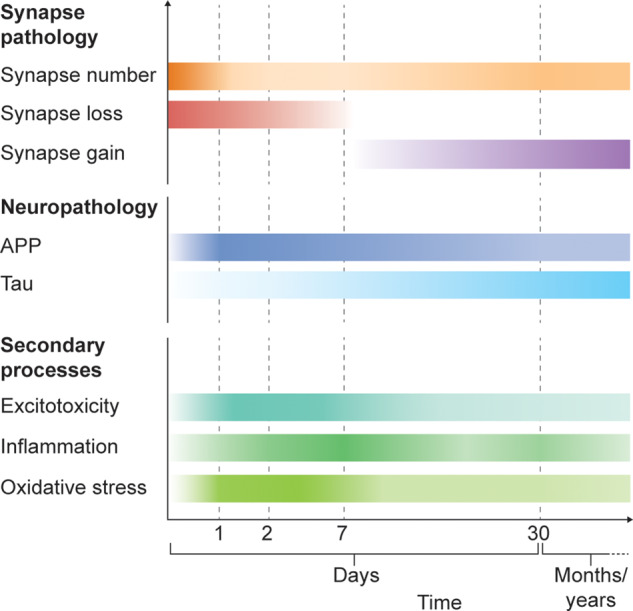

Summary of pathological changes following traumatic brain injury. After TBI, synapse density is reduced for up to 7 days, followed by a recovery which plateaus around 30 days (Scheff et al., 2005). Abnormal accumulation of APP peaks 1 day after TBI but can persist for months to years after injury (Johnson et al., 2013). Tau spreads through the brain after TBI and neurofibrillary tangles are a hallmark of chronic traumatic encephalopathy (Edwards et al., 2020). There is a rapid rise in extracellular glutamate after TBI, and levels may remain abnormally elevated up to a week from the injury (Vespa et al., 1998; Hong et al., 2001). Microglia show bimodal peaks after TBI at 7 days and then 30 days (Simon et al., 2017). Markers of oxidative stress appear rapidly after injury and may persist up to 6 months after TBI (Licastro et al., 2016).